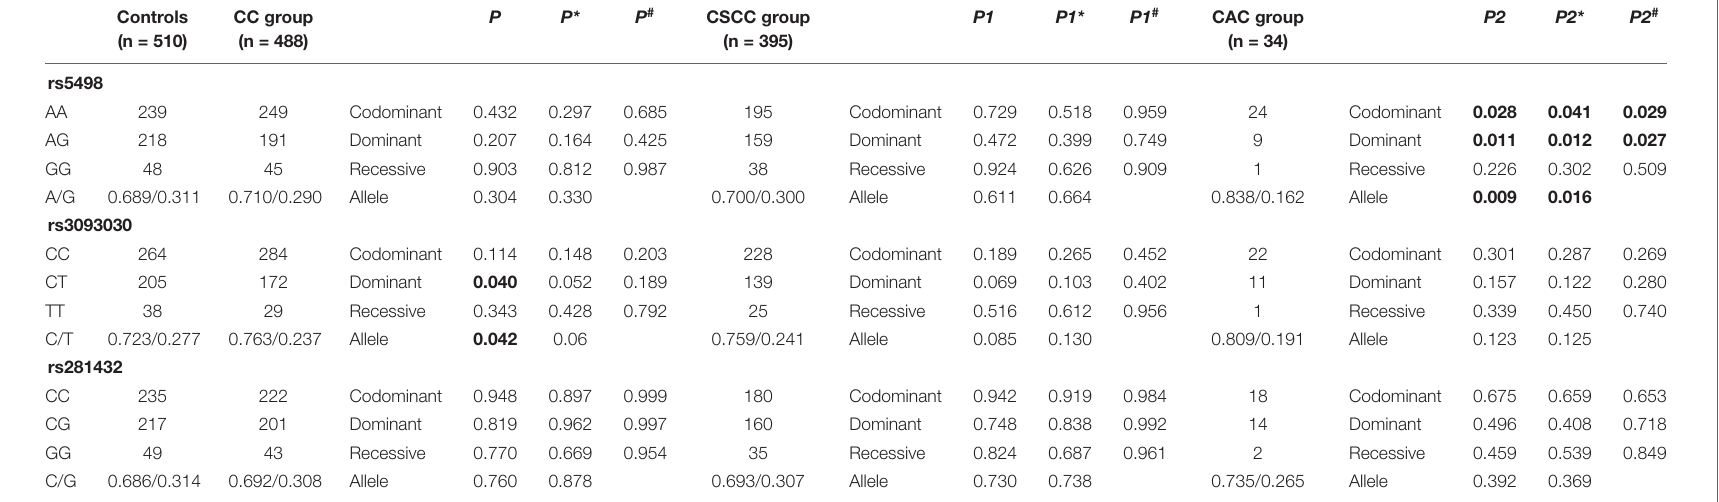
CC, cervical cancer; CSCC, cervical squamous cell carcinomas; CAC, cervical adenocarcinoma. P: controls vs. CC; P1: controls vs. CSCC; P2: controls vs. CAC. *Age was adjusted. # The p value was calculated using 10,000 permutations for each model to correct the multiple tests. Codominant with degree of freedom 2, dominant and recessive models with degree of freedom 1. p values < 0.05 are shown in